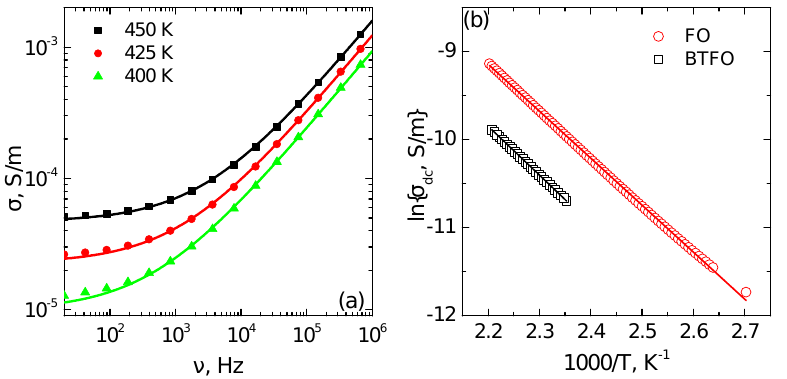
Figure 6. Frequency dependence of the conductivity of the BTFO sample. Symbols are the measured data, curves—fit with Equation (3) ( a ). The temperature dependence of the DC conductivity. Symbols—measured results; curves—Arrhenius fit ( b